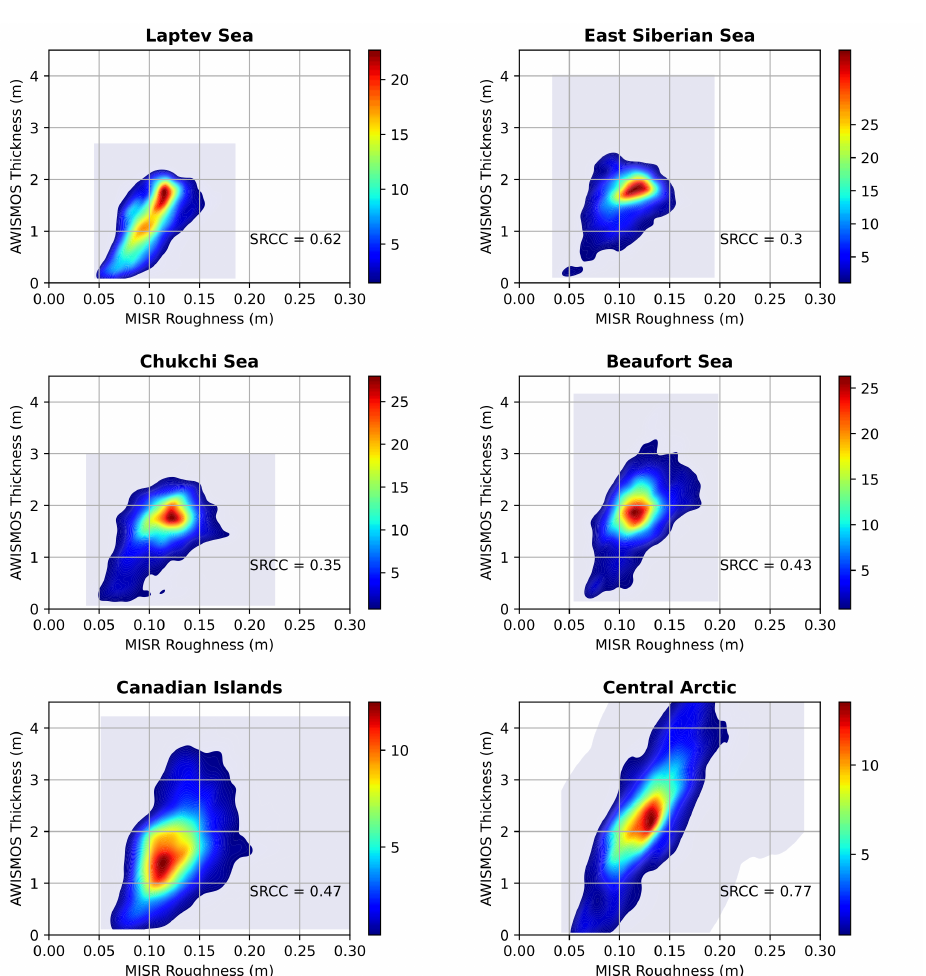
Figure A2. Two-dimensional scatter plot shows a bivariate distribution between MISR-derived roughness (m) and AWI CS-2 SMOS merged thickness (m) for 01–15 April 2011–2020 and 25 km resolution, for each Arctic region defined in Figure A1. Similar to Figure 12 the count density refers to measurements over a 300 300 grid over the presented range (per 1.5cm of thickness and per mm × of roughness). The opaque shaded region represents 95% of the range, contours for the remaining percentiles are at single increments, and the valid bounds are in light